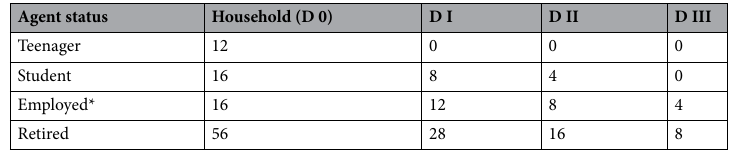
Table 3. Amount of care agents can provide depending on their status and kinship distance from the care receiver. *Employed agents can provide additional care if they choose to reduce their working hours (i.e. in case it is more convenient than using income to pay for formal care. See the Formal Care section for